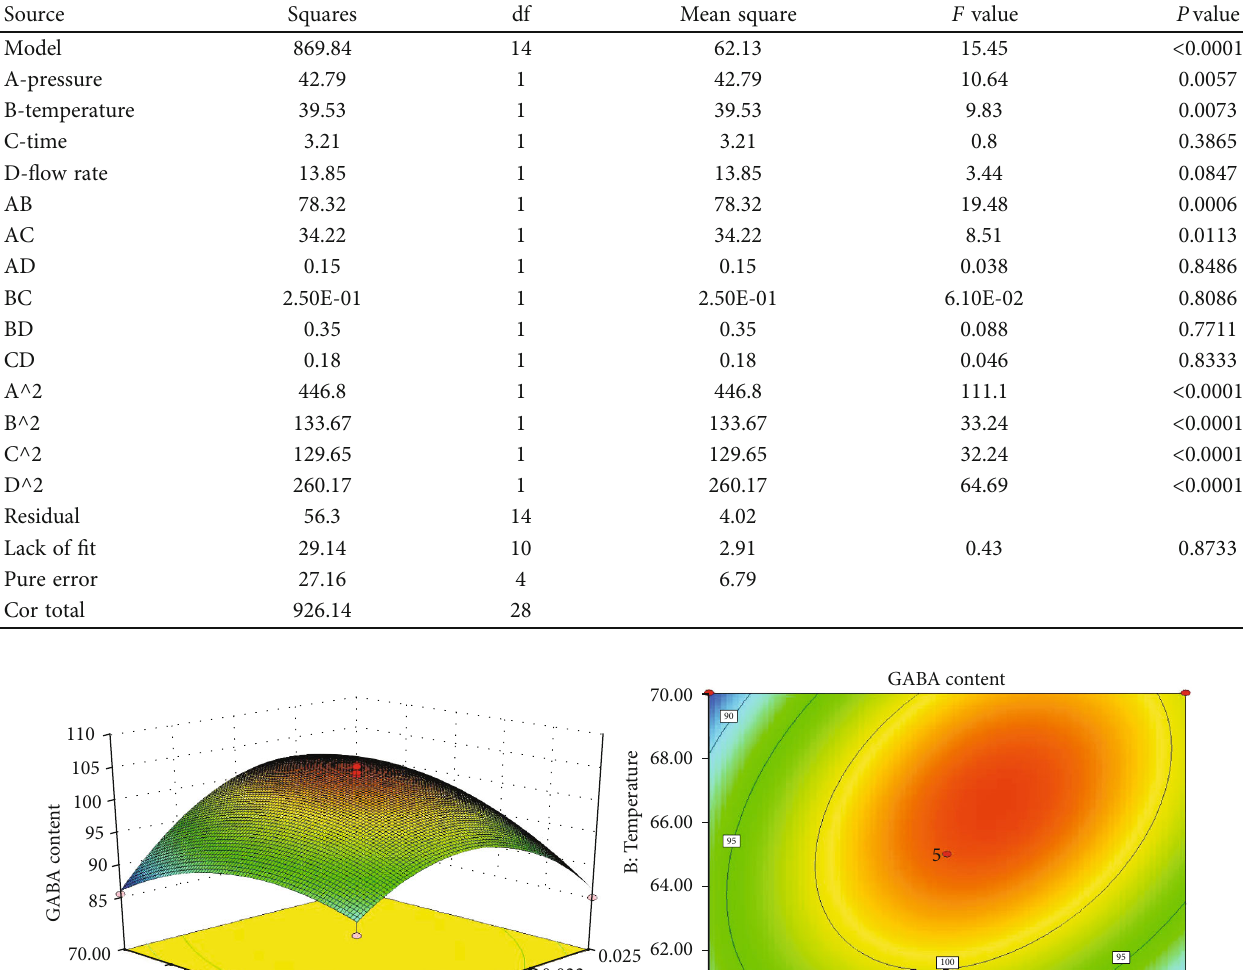
Table 6: Analysis of ANOVA with secondary regression of the low-pressure overheated steam response surface.